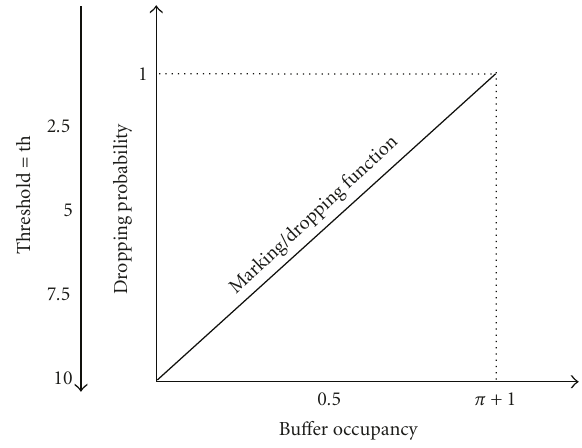
Figure 10: Marking/dropping function with threshold.